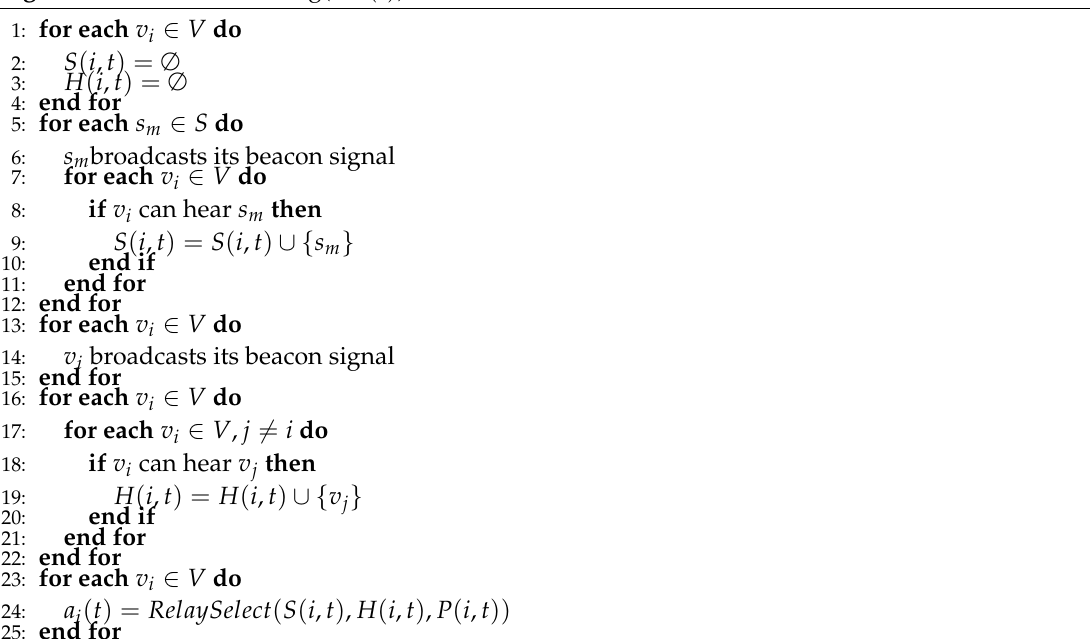
Algorithm 1 DataForwarding( t , C ( t )